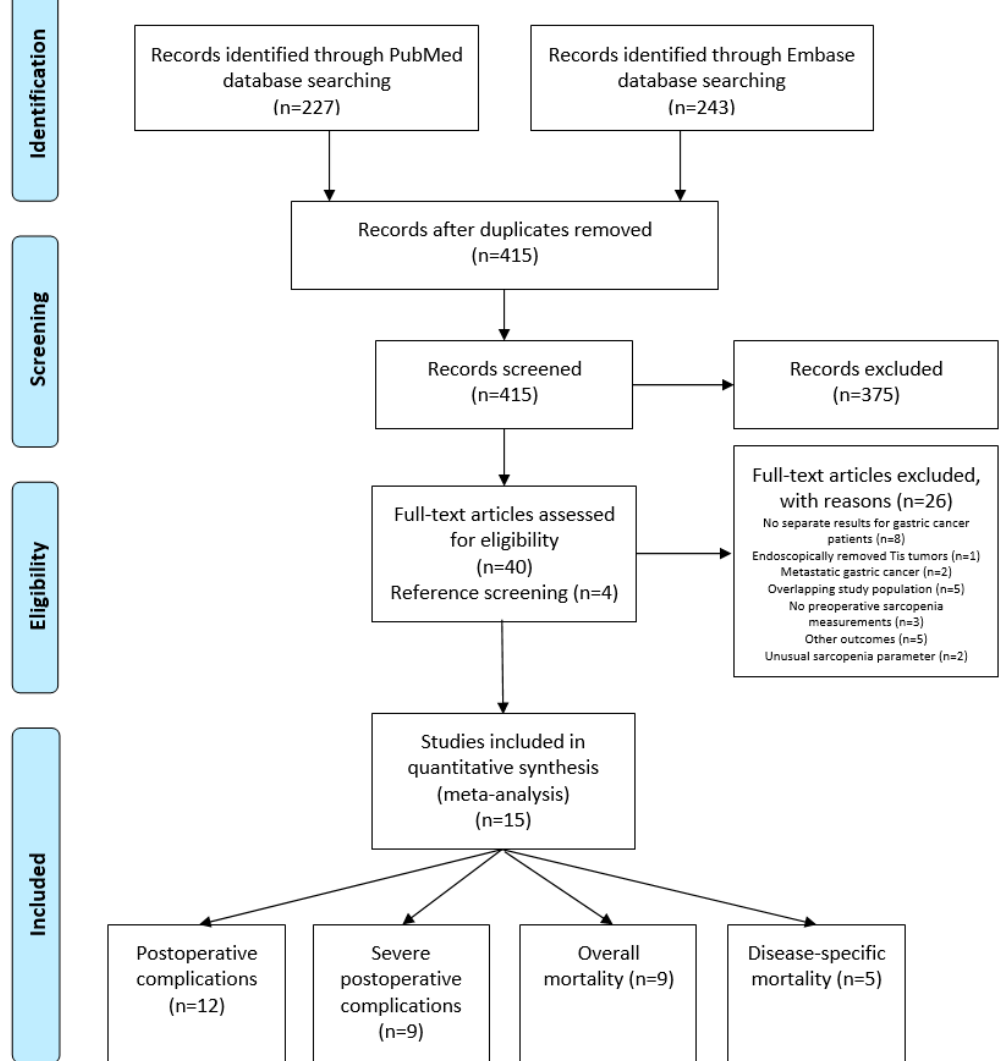
Figure 1. Preferred Reporting Items for Systematic Reviews and Meta-Analyses (PRISMA) flow diagram of literature search.